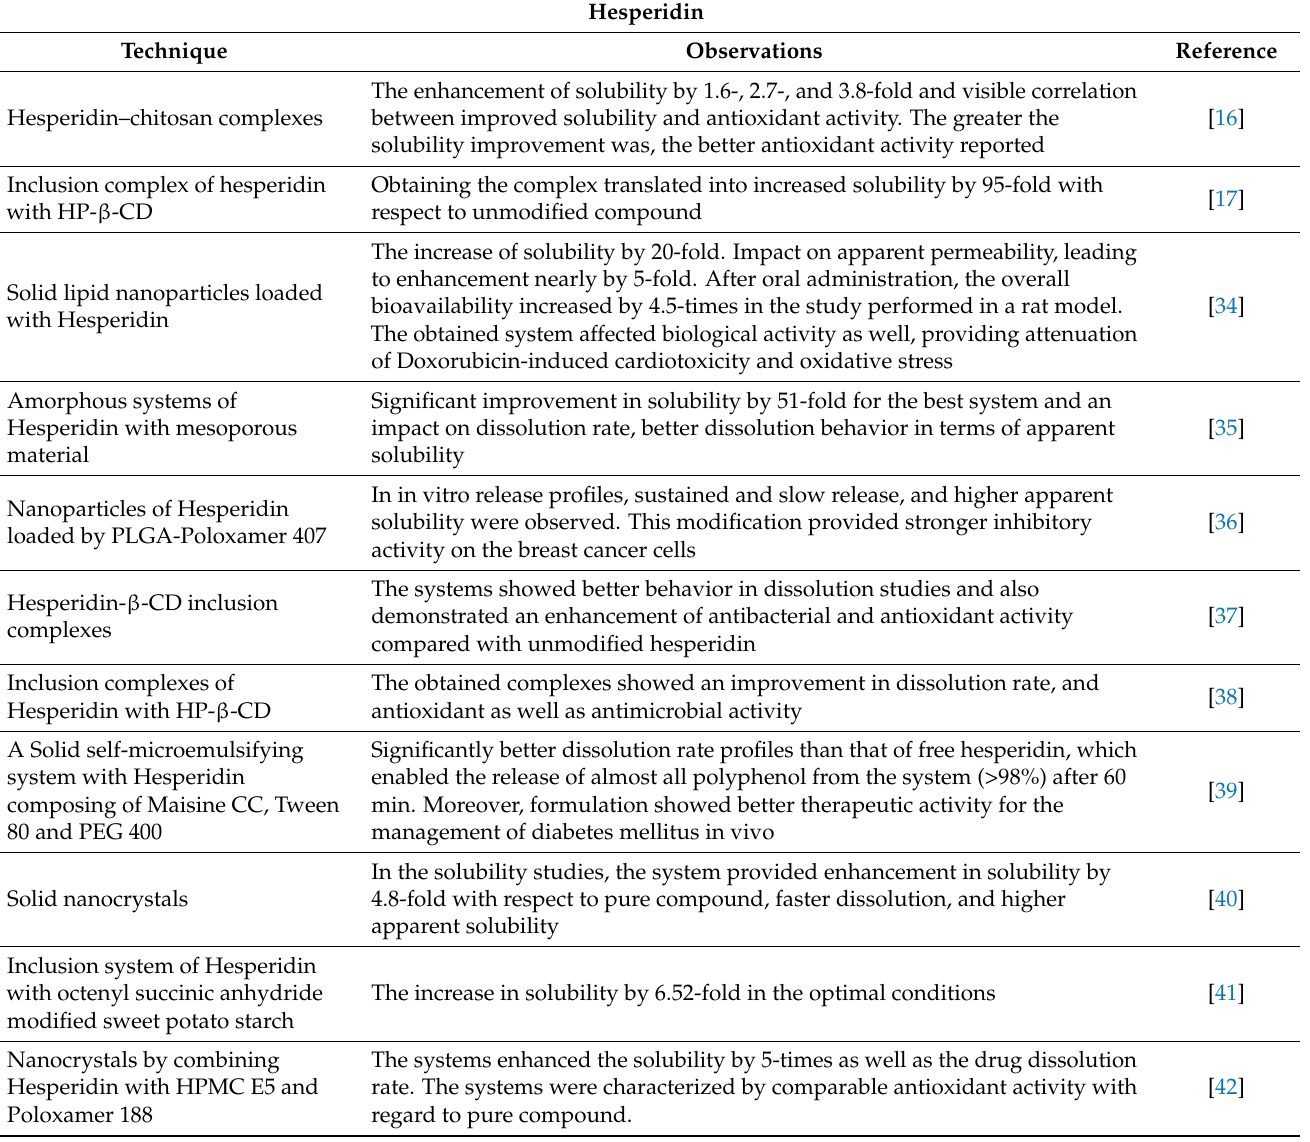
Table 1. Collected attempts to increase the bioavailability of hesperidin and